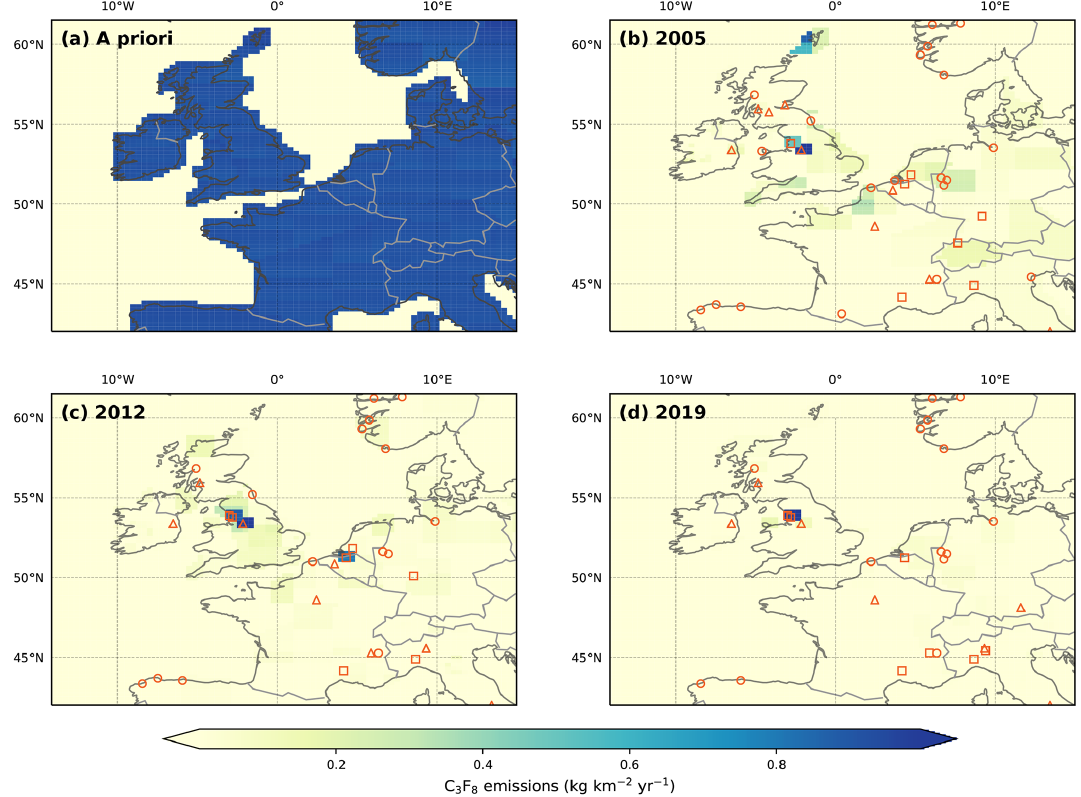
Figure 10. Northwest European C 3 F 8 emissions in kgkm − 2 yr − 1 . (a) The a priori emissions field. With the exception of the oceans, emissions were distributed uniformly across the model domain. A posteriori emissions are shown for (b) 2005, (c) 2012 and (d) 2019. Facilities that reported PFC emissions to the E-PRTR in the selected year are shown as orange circles (aluminium smelters), triangles (electronics manufacturers) and squares (chemical manufacturers, including petroleum products). Since the reporting period for the E-PRTR is shorter than that of our measurements, 2005 and 2019 emissions are compared to the earliest (2007) and latest (2017) years of the E-PRTR database, respectively. Note that the E-PRTR database reports cumulative PFC emissions.